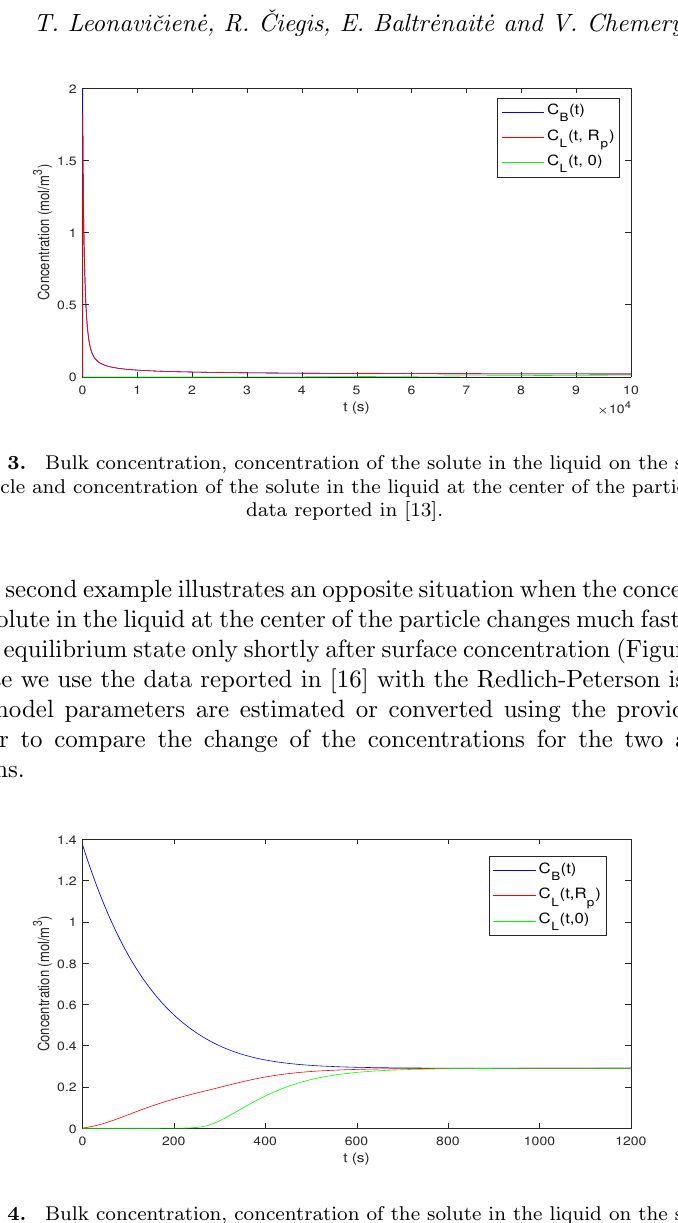
Figure 4. Bulk concentration, concentration of the solute in the liquid on the surface of the particle and concentration of the solute in the liquid at the center of the particle for the data reported in